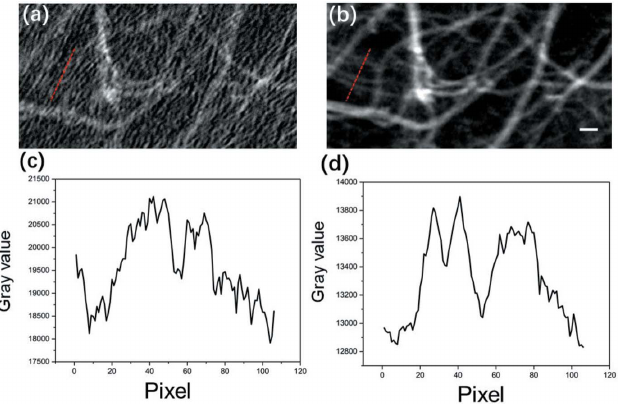
Figure 3 Perfusion process of contrast agent in mouse cerebral blood vessels, where ( a ), ( c ), ( e ), and ( g ) are images of the perfusion process at different phases obtained using the traditional temporal subtraction method, whereas ( b ), ( d ), ( f ), and ( h ) are the counterpart images obtained using PTA. Scale bar: 1 mm.